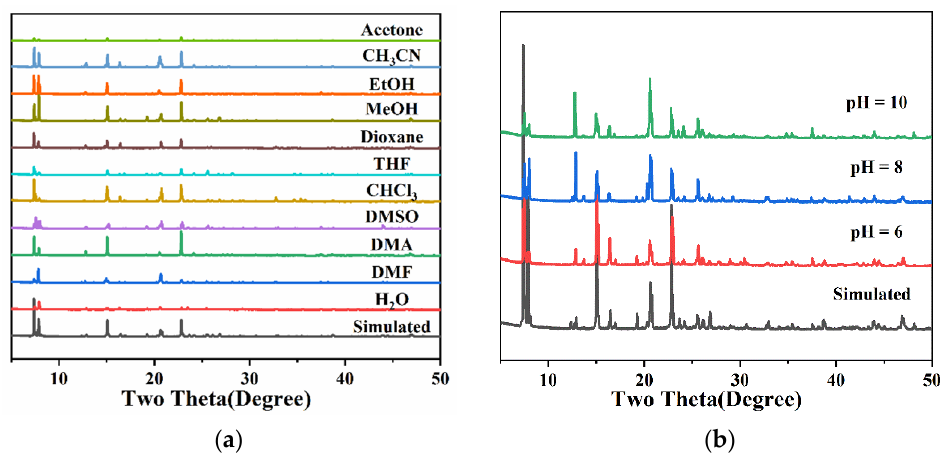
Figure 3. PXRD patterns of simulated (black) and after being immersed samples in different solvents of 1 ( a ); PXRD patterns of simulated (black) and after being immersed samples under different pH conditions of 1 ( b ).